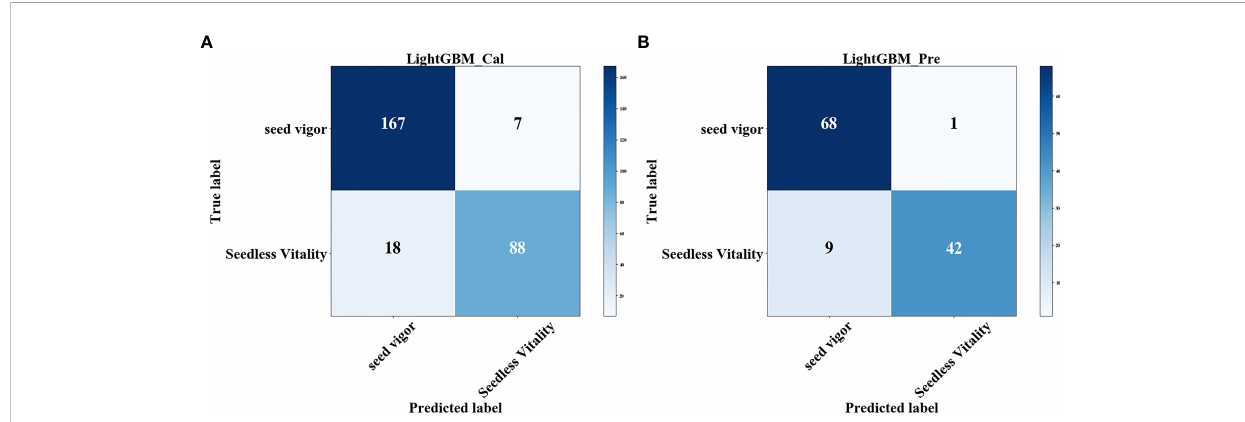
FIGURE 6 MF-CatBoost-LightGBM confusion matrix: (A) Training set confusion matrix; (B) prediction set confusion